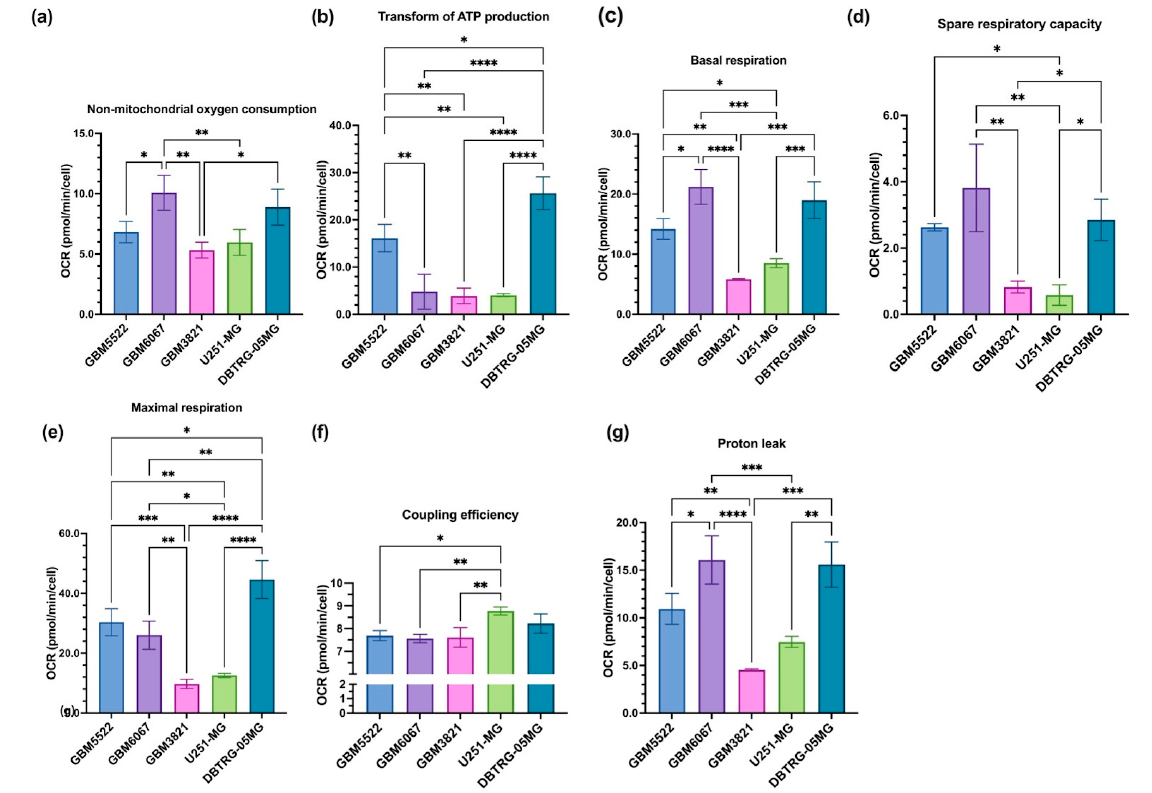
Figure 8. Enhanced oncolytic activity of CVB5 towards glioblastoma cell lines correlates with their basal mitochondrial respiration and spare respiratory capacity. Non-mitochondrial oxygen con-